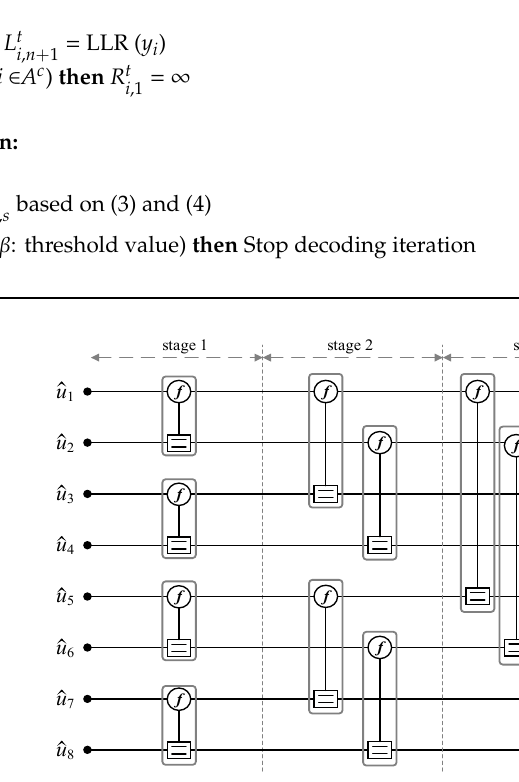
Figure 1. Factor graph of polar belief-propagation (BP) decoder for (8, 4) polar code.